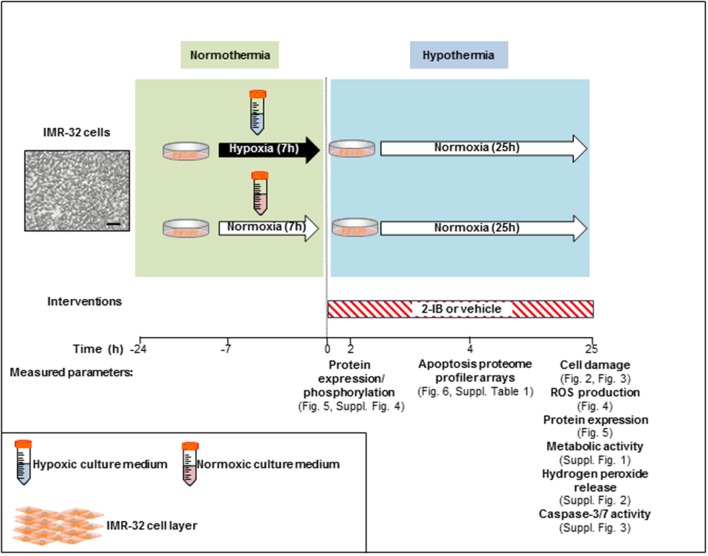
Experimental setup.